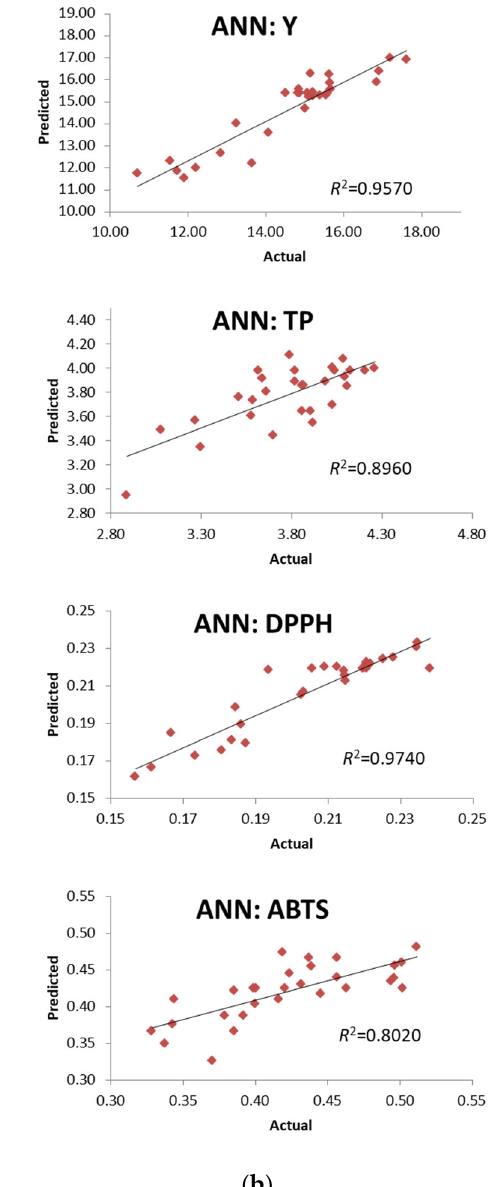
Figure 1. Comparison of experimentally observed and predicted values determined by ( a ) RSM and ( b ) ANN.